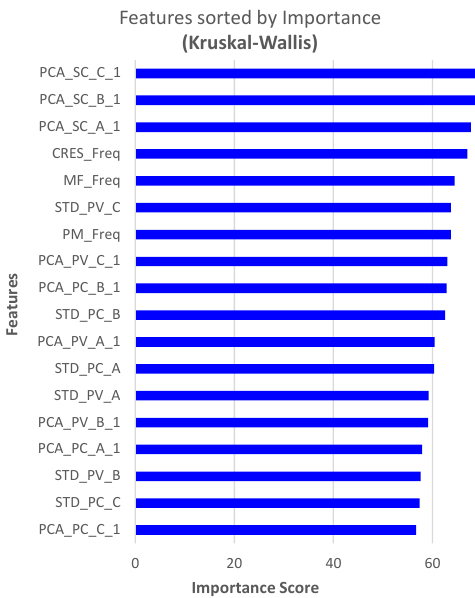
Figure 18. Feature ranking for FD using KW.